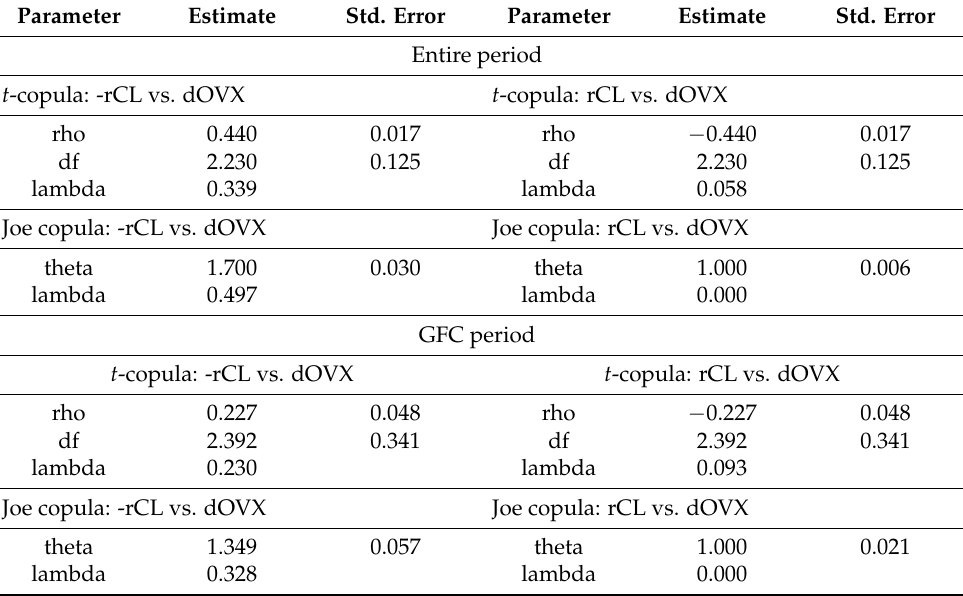
Table 1. Copula parameters and tail dependence coefficient for Crude Oil Future Contract returns (rCL) and changes in the CBOE Crude Oil Volatility Index (dOVX) in the entire period and sub-